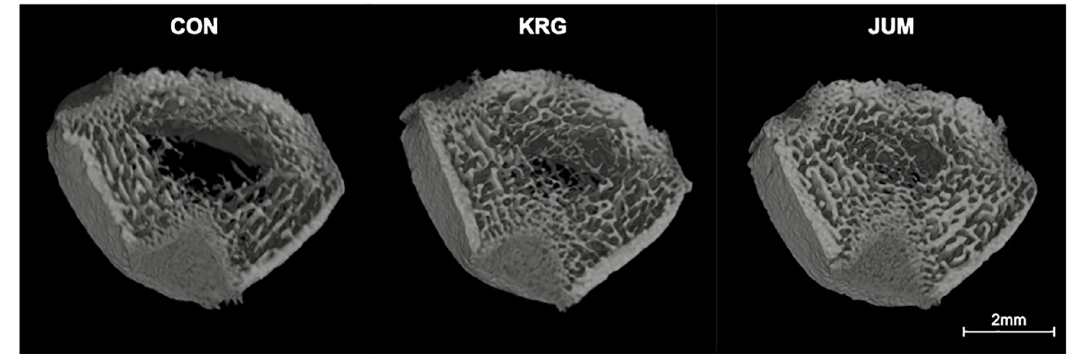
Fig 4. Representative three-dimensional micro-CT images of trabecular bone of the distal femoral metaphyseal region from each group were reconstructed. KRG, group administered 200 mg/kg body weight of Korean red ginseng daily; JUM, group that jumped 10 times/day from a height of 40 cm; CON, control group without exercise or KRG administration.